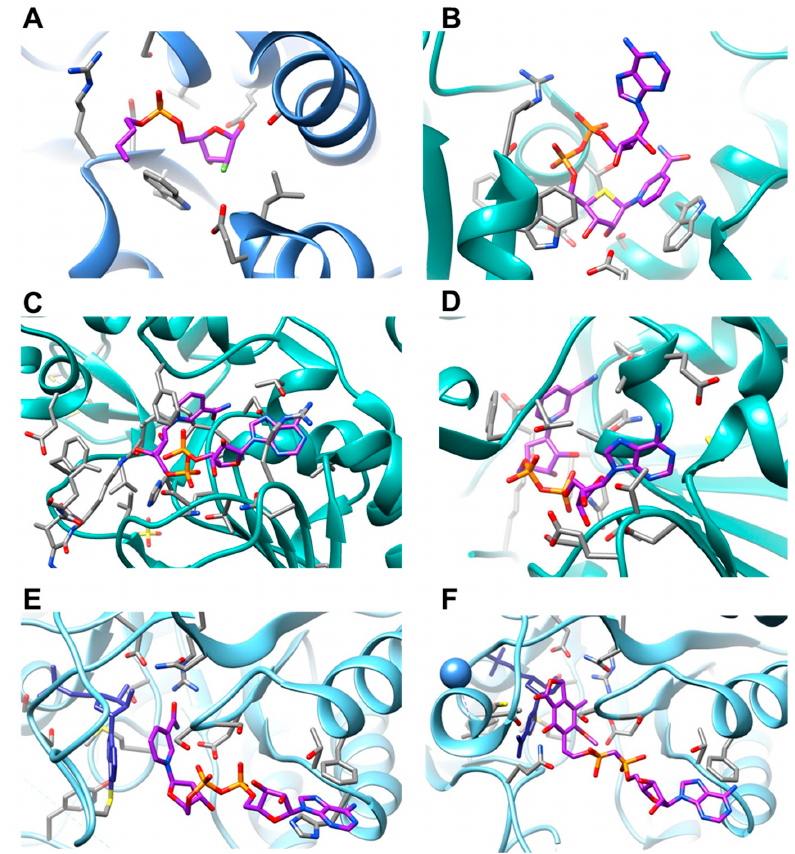
Figure 7. Crystallographic structures of representative NAD + or analogs in complexes with target proteins. ( A ) NAD + analog 28 bound to CD38 (enzyme labelled in blue) PDB code: 3ROK; ( B ) S-NAD + 39 bound to SIRT2 (enzyme labelled in green), PDB code: 6EDR; ( C ) carba-NAD + 33 bound to SIRT3 (enzyme labelled in green), PDB code: 4FVT; ( D ) carba-NAD + 33 bound to SIRT5 (enzyme labelled in green), PDB code: 4G1C; ( E ) NAD + bound to h IMPDH2 (enzyme labelled in light blue), PDB code: 1NFB; ( F ) MAD 44 bound to h IMPDH2 (enzyme labelled in light blue, ligand labelled in dark blue), PDB code: 1NF7. General labels for all the structures: carbon from NAD + analog in purple, carbon from amino acid side chains in grey, oxygen in red, nitrogen in blue, phosphorus in orange and sulfur in